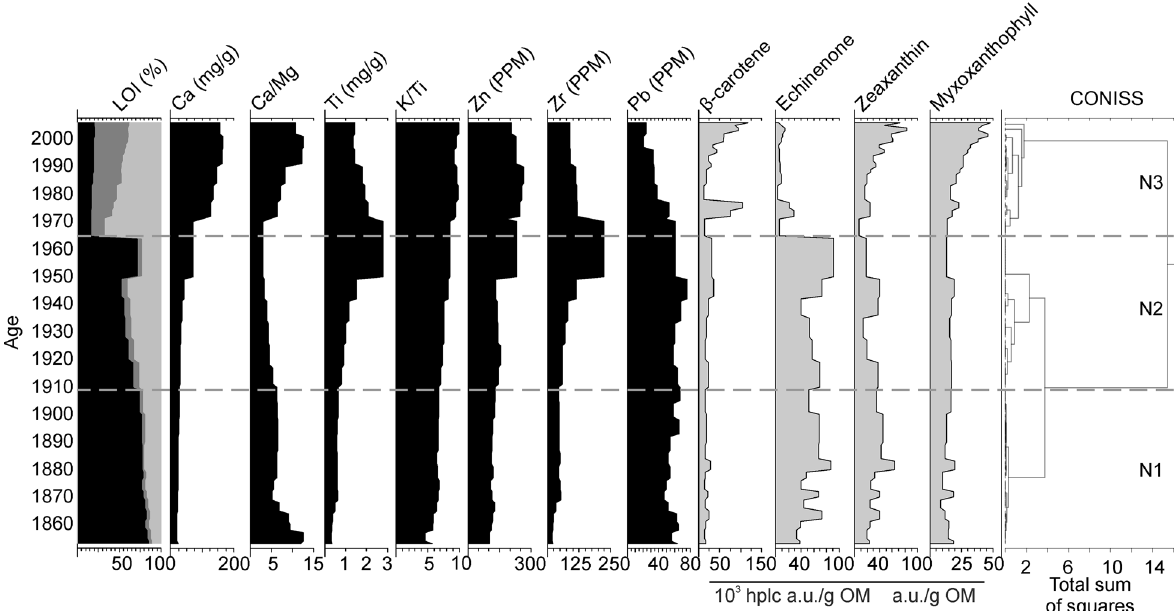
Fig. 4. Selected variables from the sediment of Lake Nõmmejärv in age scale and results of CONISS analysis of all data (40 variables). Loss on ignition (LOI 550 and 950) data are marked as follows: black – organic matter; dark grey – CaCO 3 ; light grey – siliciclastic mineral